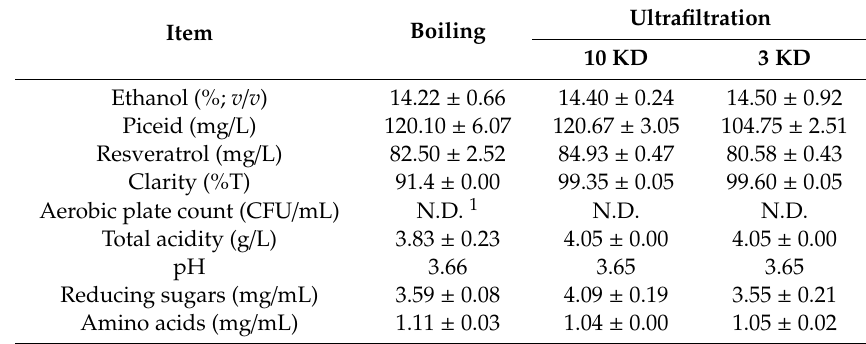
Table 2. Quality characteristics of resveratrol-enriched rice wine treated by boiling and ultrafiltration. Item